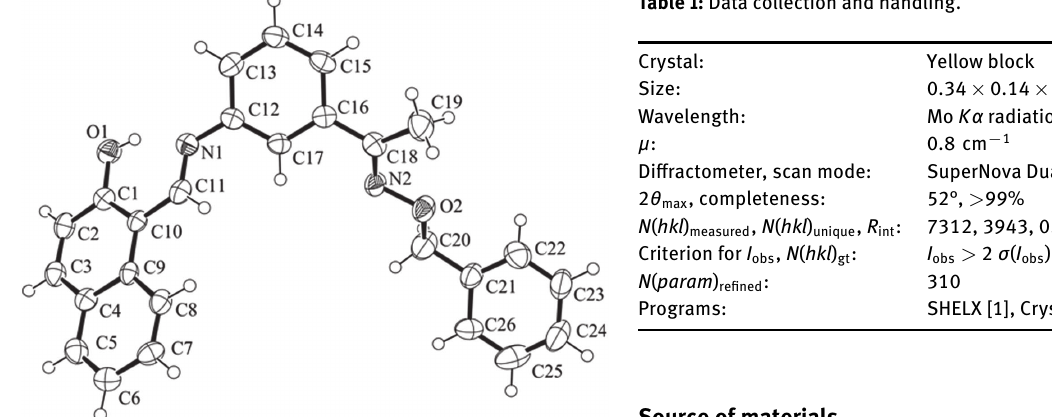
Table 1: Data collection and